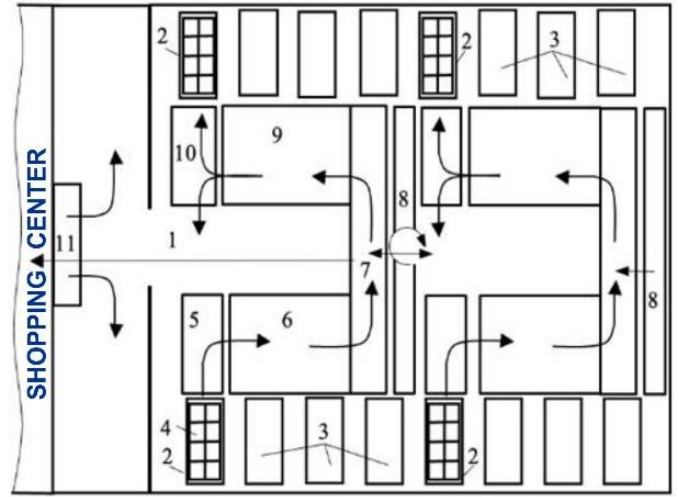
Figure 4. Spatial plan of loading–unloading operations of the CCs on the CLN4.0 floor, with four freight elevators for servicing: 1—operation floor of the CLN4.0, 2—four freight elevators for floor servicing, 3—freight elevators for servicing other floors of CLN4.0, 4—CCs, 5—the input zone of the CCs on the CLN4.0 floor, 6—buffer and unpicking zone of the CCs on the CLN4.0 floor, 7—freight sorting zone of the IRTs on the CLN4.0 floor, 8—mobile storage for freights distributed in sections, 9—sorting, picking, and buffer zone of the CCs on the CLN4.0 floor, 10—output zone of the CCs on the CLN4.0 floor; 11—passenger and freight elevators, which serve all groups of the CLN4.0 floors and shopping center.